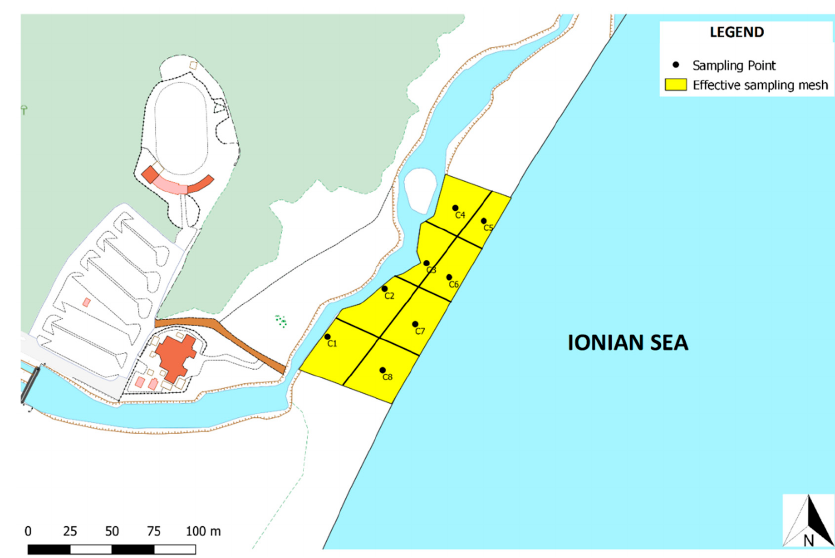
Figure 4. Location of sampling points: sampling mesh.